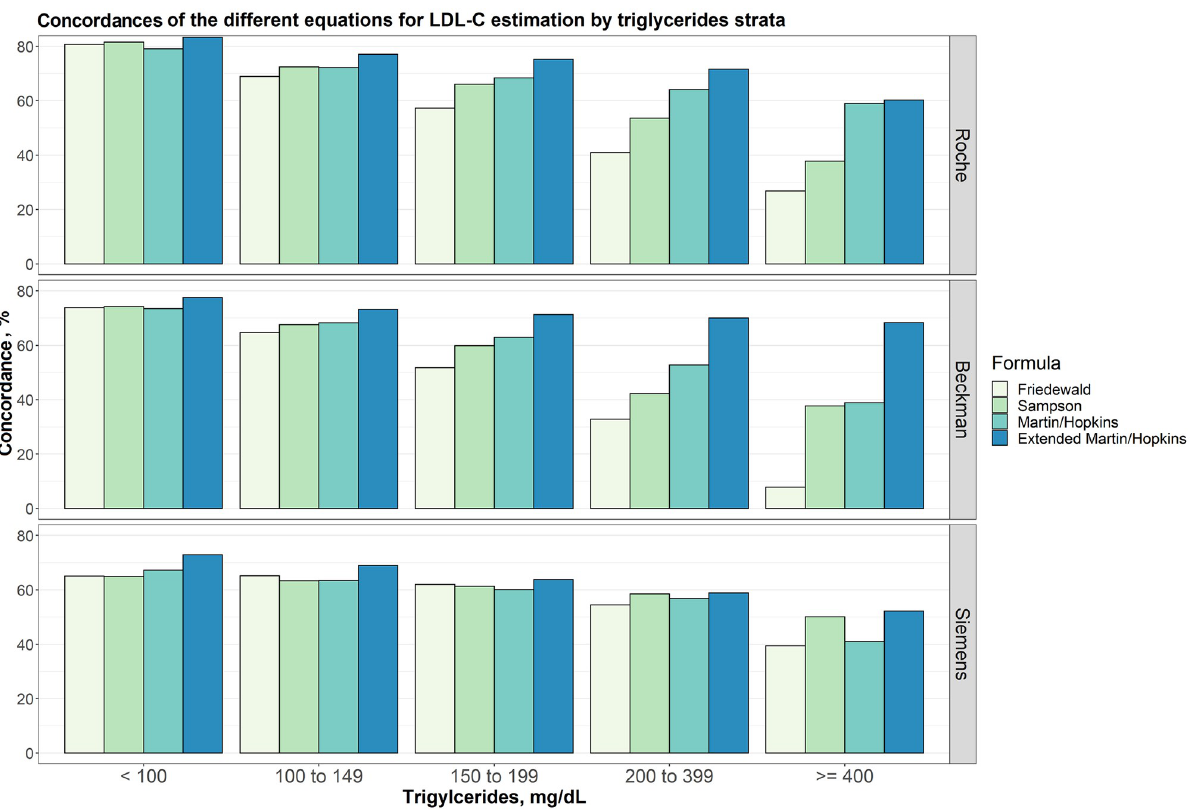
Fig 4. Concordances of the different equations for LDL-C estimation by triglycerides strata. Concordances of different equations for LDL-C estimation by triglycerides groups for different direct measures (i.e., Roche, Beckman and Siemens) are given in a clustered bar chart. Each bar indicates the concordance of estimating LDL-C levels by different formulas for each group of triglycerides concentration given that the LDL-C levels measured by Roche, Beckman and Siemens direct methods, accordingly.